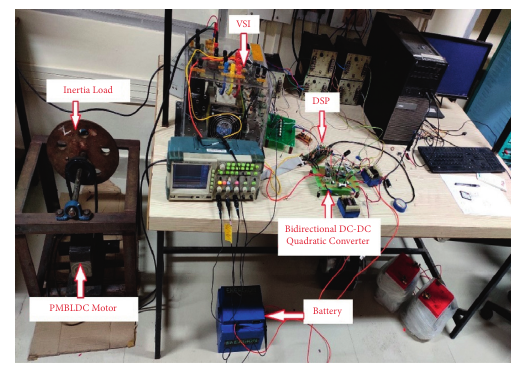
Figure 19: Hardware setup.